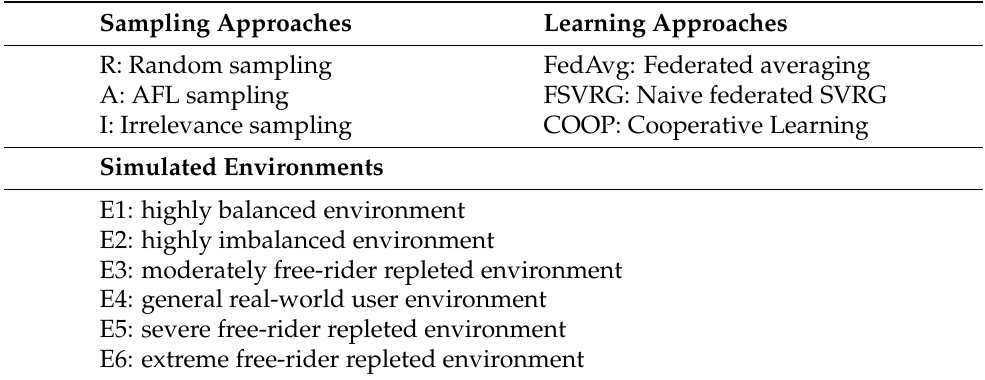
Table 2. Details of experimental variations considered for both IID and non-IID